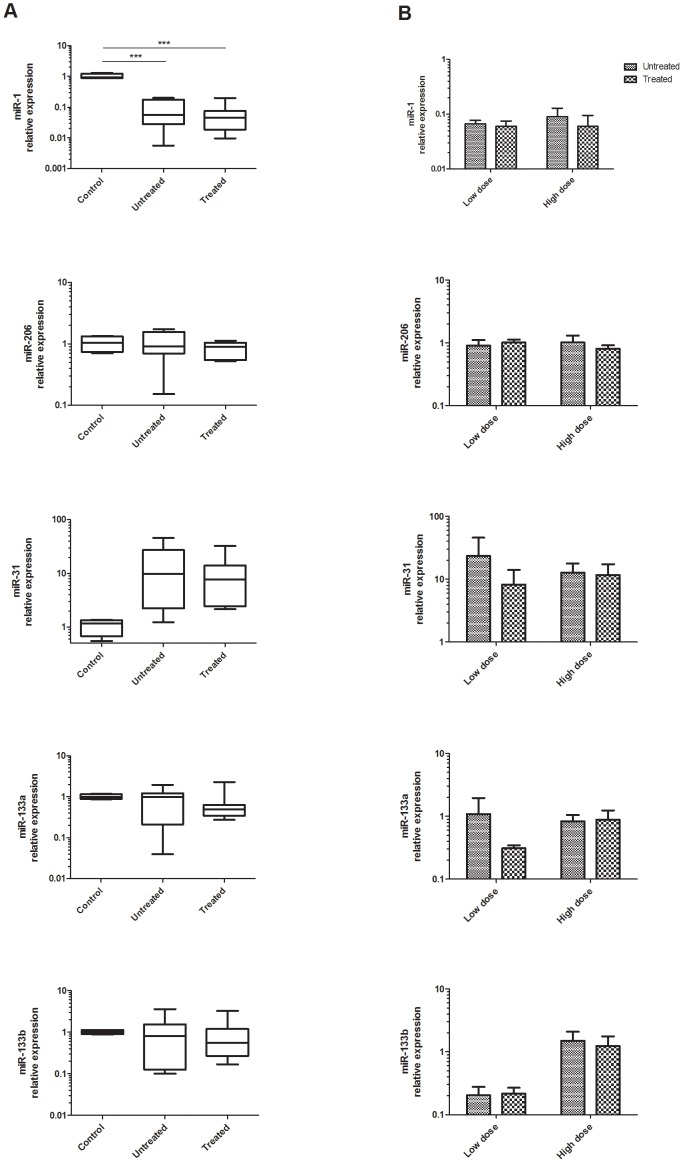
miRNAs as biomarkers for the outcome of therapeutic interventions: Intramuscular eteplirsen treatment trial.MiR-1, miR-206, miR-31, miR-133a and miR-133b expression in: A. untreated and treated muscle biopsy samples and controls; B. patients who received low dose and patients with high dose of eteplirsen. The data are presented in a logarithmic scale as relative fold change with respect to the control samples and normalized to U6 snRNA expression. P-values derived from two-tailed t-test are presented with *** and correspond to p<0.001.